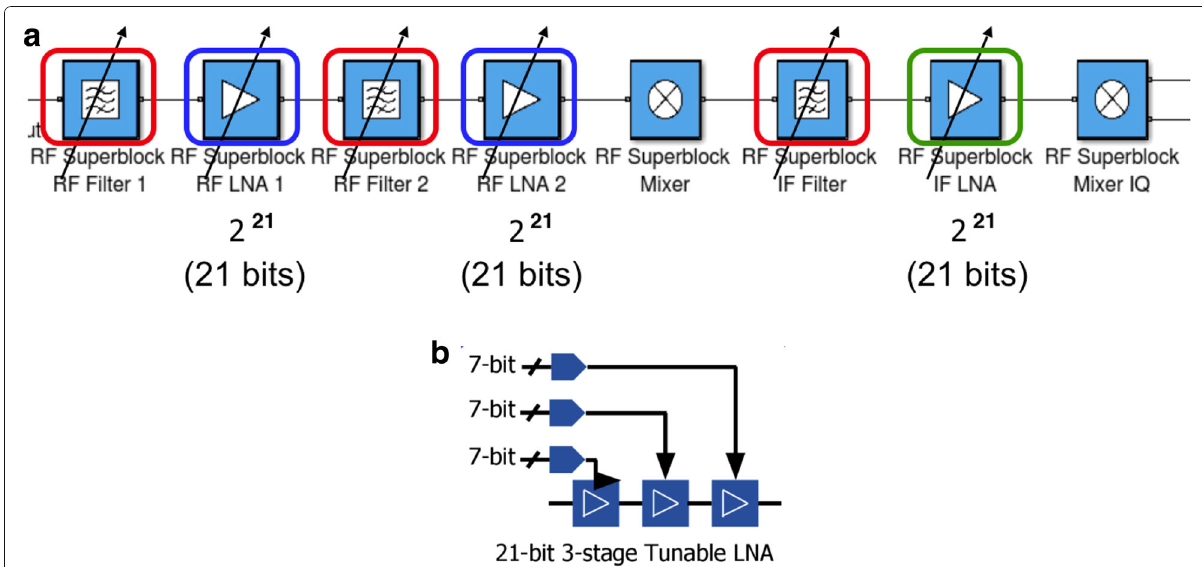
Fig. 2 An example of a large-scale RF-FPGA system with 63 bits of control: each of three tunable amplifiers in ( a ) has 21 bits of control. Each tunable amplifier with 21 bits of control is composed of three cascaded tunable amplifiers with 7 bits of control as shown in ( b )